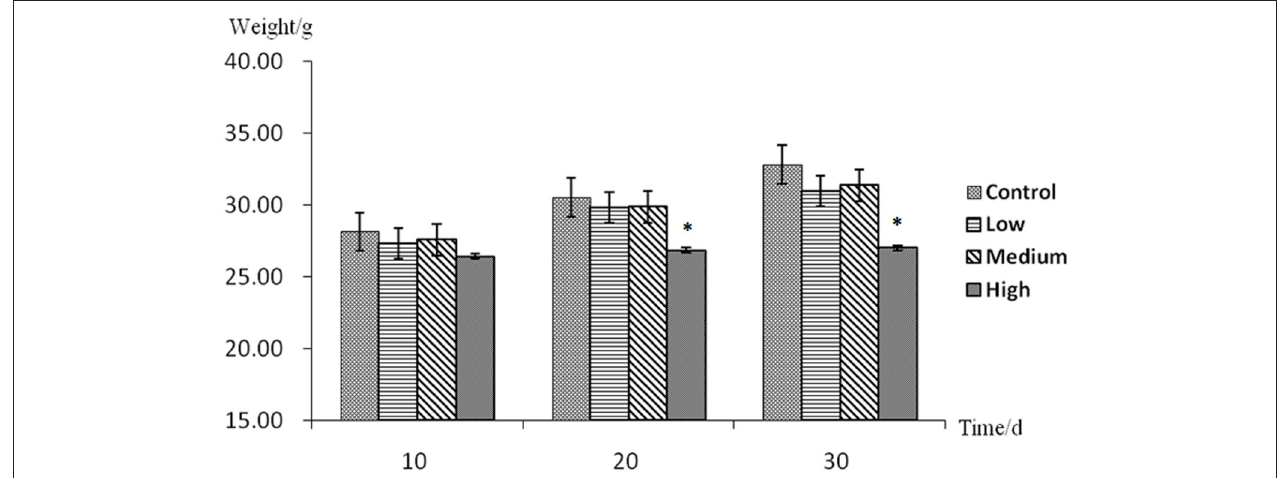
TABLE 1 | Changes of organ coefficient in mouse with subacute aconitine poisoning. Control Low-dose Middle-dose Item Group